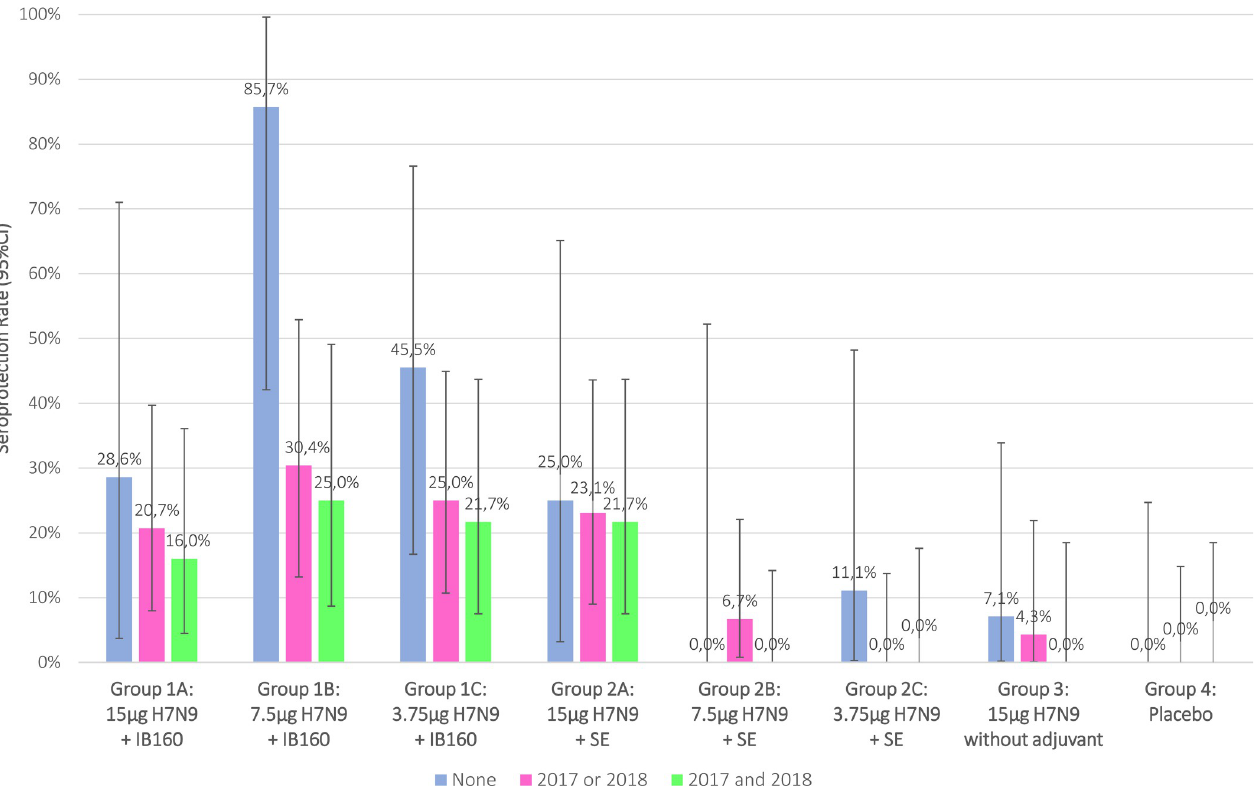
Fig 4. Association of HI seroprotection rate after 28(+7) days post 2nd dose administration with prior receipt of seasonal influenza vaccine, intention- to-treat analysis.